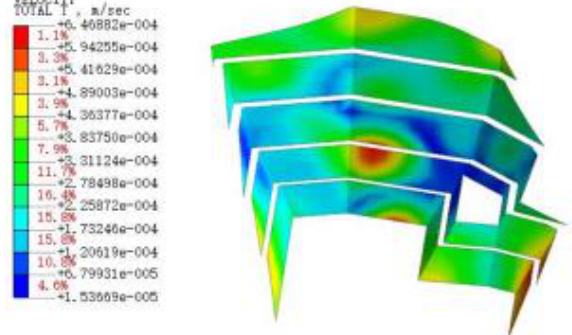
Figure 21. The vibration velocities of retaining walls at 1000 ms.